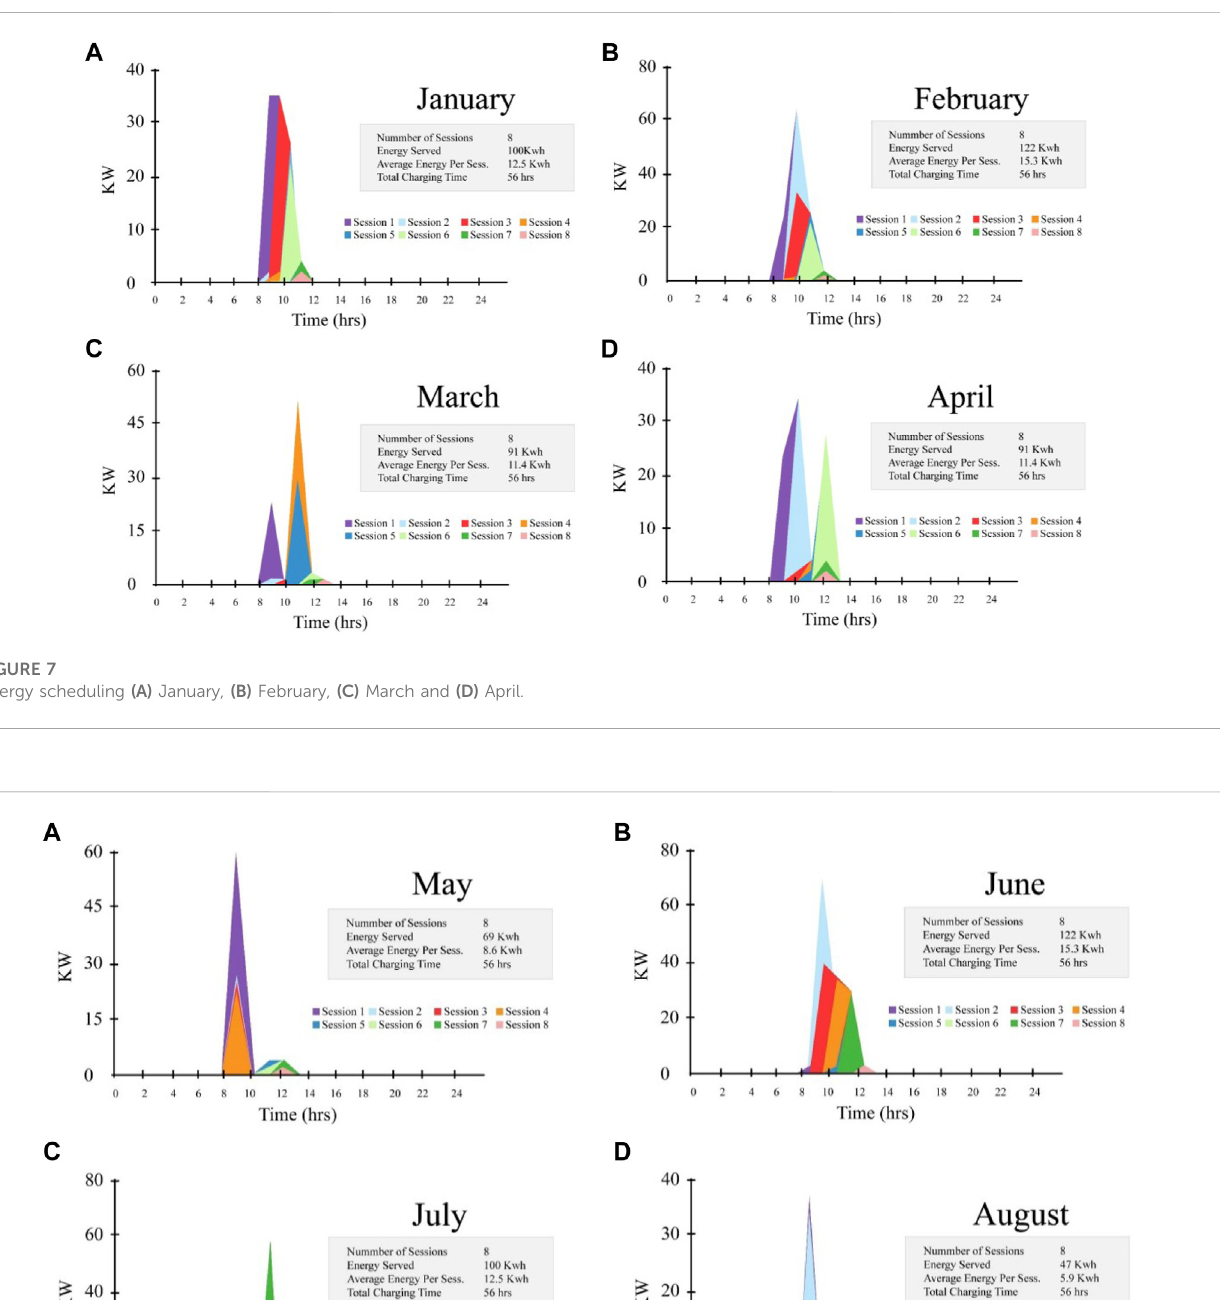
losses of .4% and soiling losses of 2.0%. 5.6% of the system ’ s losses are caused by changes in temperature, and 3.1% of the system ’ s losses are due to mismatches. The system experiences clipping and wiring loss of .7%, for a total loss value of 34.1% as shown in Figure 12.